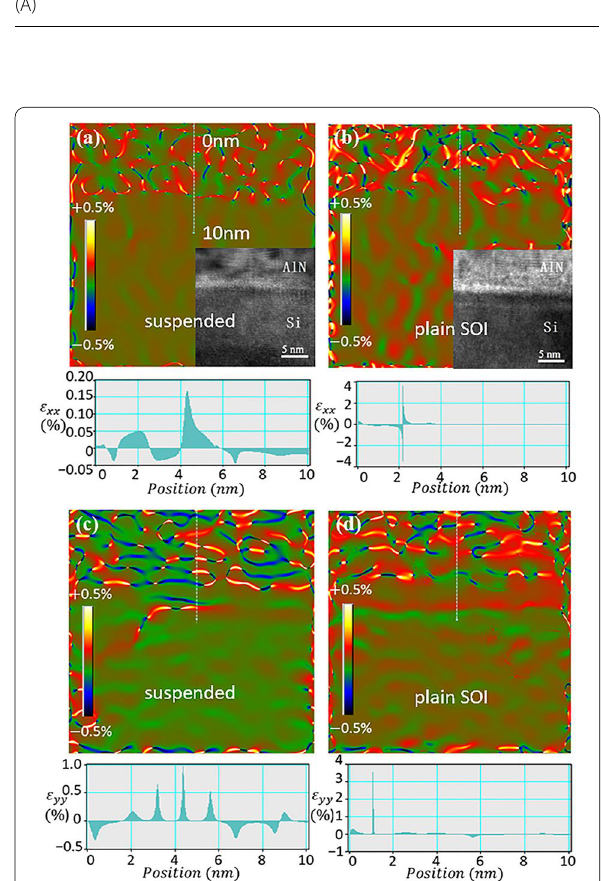
Fig. 6 HRTEM images of the effectively suspended zone, and the strain map distribution ( a , c ). HRTEM images of plain SOI sample, and the strain map distribution ( b , d ). The strain map distribution and its respective vertical line profile along the ε xx direction ( a , b ), and the ε yy direction ( c , d ). In each image, the GPA maps are generated by defining an unstrained reference area in the Si layer, and the strain values are the relative value of the compressed Si lattice. To emphasize the contrast at the Si area, the color scale was tuned at − 0.5% to 0.5 % +